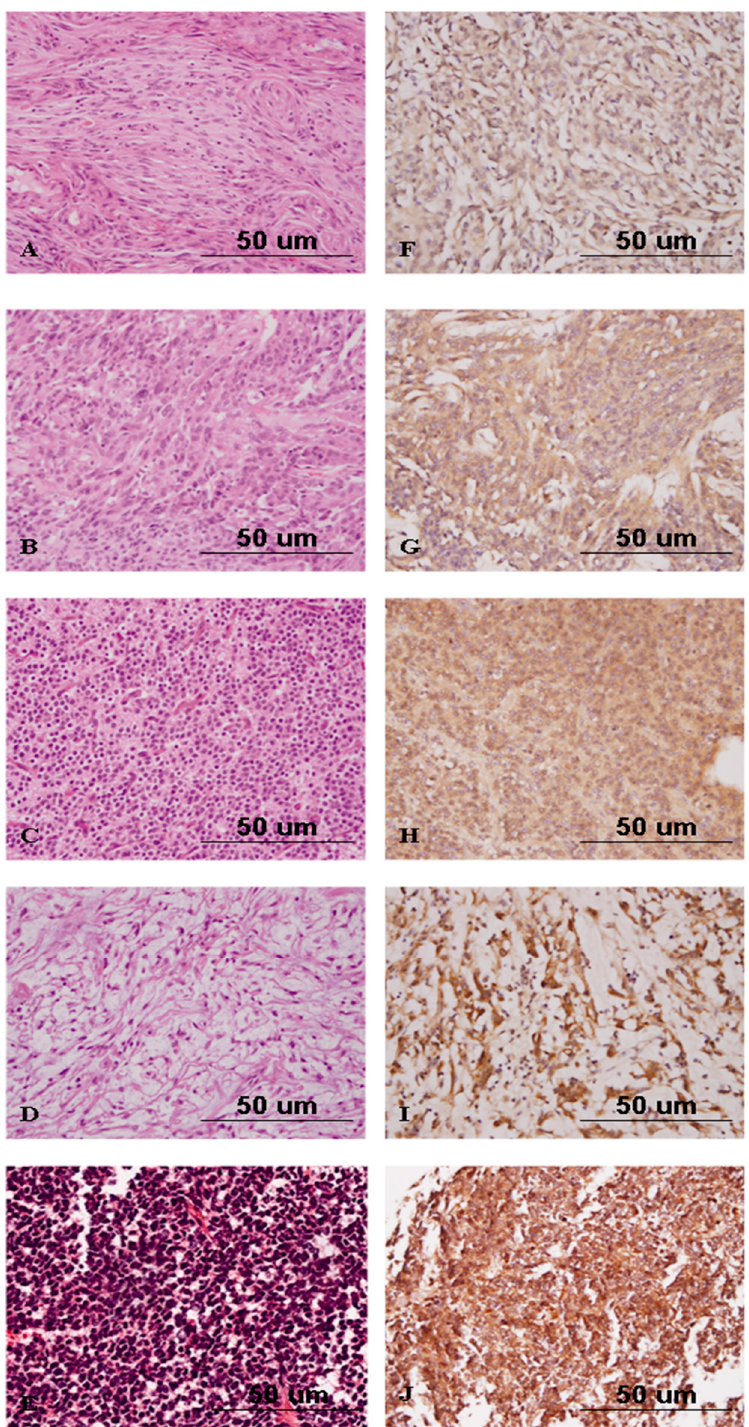
Figure 6. Hematoxylin and eosin staining of meningothelial meningioma ( A ); atypical meningioma ( B ); central neurocytoma ( C ); chordoma ( D ); and medulloblastoma ( E ); and immunohistochemical analysis of Nrf2 in meningothelial meningioma ( F ); atypical meningioma ( G ); central neurocytoma ( H ); chordoma ( I ); and medulloblastoma ( J ) (original magnification ×400).